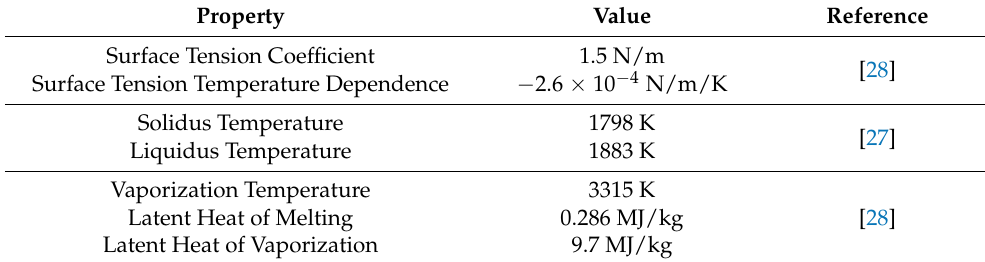
Table 2. Material property inputs for